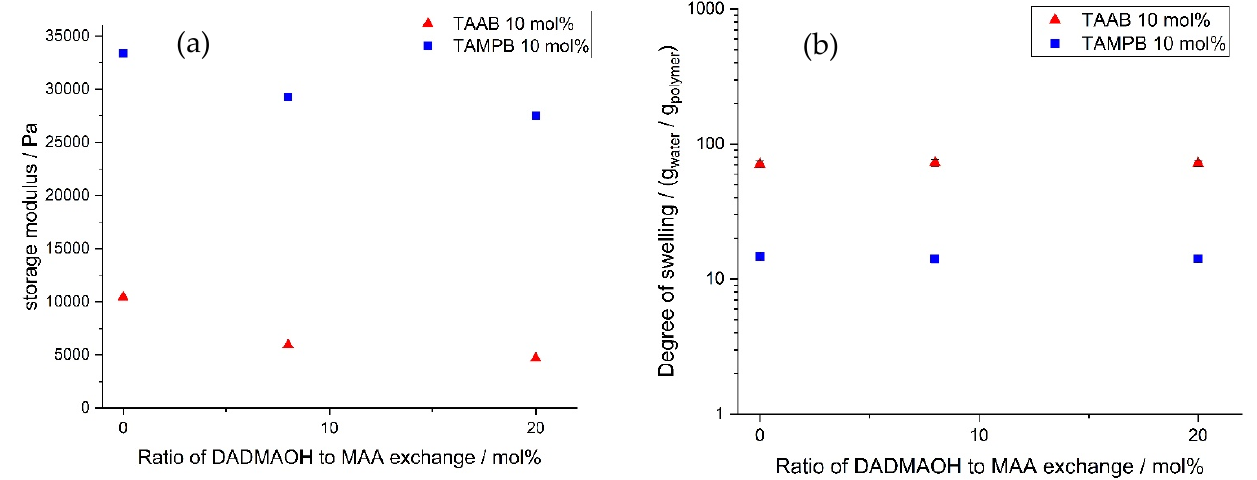
Figure 5. Storage modulus ( a ) and equilibrium degree of swelling ( b ) of gels crosslinked with 10 mol% TAAB (triangles) and TAMPB (squares), as a function of the molar fraction of methacrylamide. The storage modulus was determined at an amplitude of 1%, a frequency of 1 Hz, and a contact pressure of 5 N.